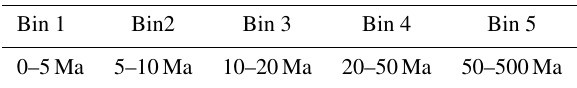
Figure 3. Results of the method applied to the first set of syn- thetic datasets. Computed erosion rate distributions for four syn- thetic datasets. For each distribution, the box extends from the lower to upper quartile values, the line corresponds to the median value, and whiskers extend from the box to show the range of the erosion rate estimates, excluding outliers. Outliers are indicated by small circles past the end of the whiskers. For each site, the gray stars cor- respond to the imposed erosion rates and the dashed gray line gives the product of the imposed area and fertility factors, F i = A i α i . Table 1. Age bins used to construct age distributions shown in Fig. 8 and used in our example.